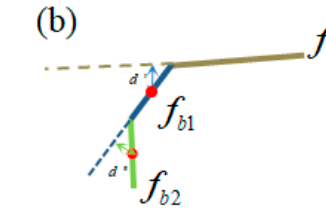
Figure 7. The granularity of over-segmentation affects the result of facet region growing. ( a ) shows the side view of a facet set containing only two adjacent facets, and ( b ) shows the side view of a facet set containing three adjacent facets. If the facet f b in ( a ) breaks into two parts, f b 1 and f b 2 ; In ( b ), the distance from f b 1 to f a is much smaller than the distance from f b to f a , making the region growing to be easier.